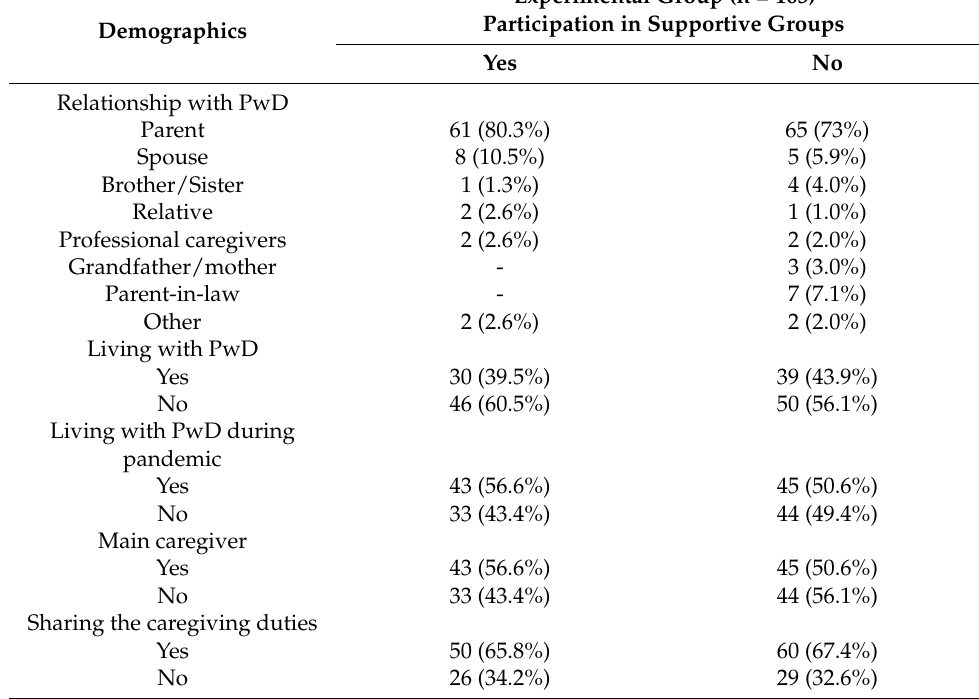
Table 3. Caregivers’